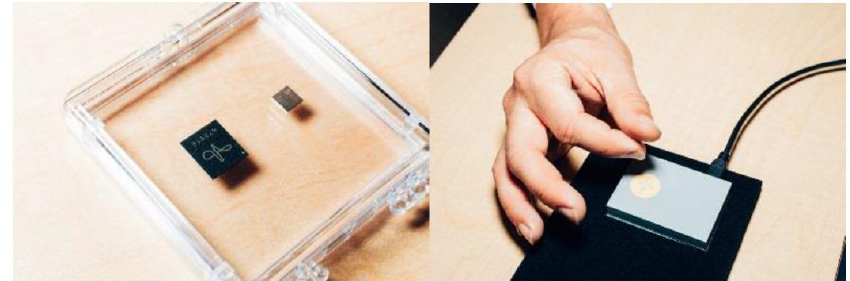
Figure 8. The challenge of Soli was to shrink the radar to the size of a computer chip. Peter Mccollough for Wired.